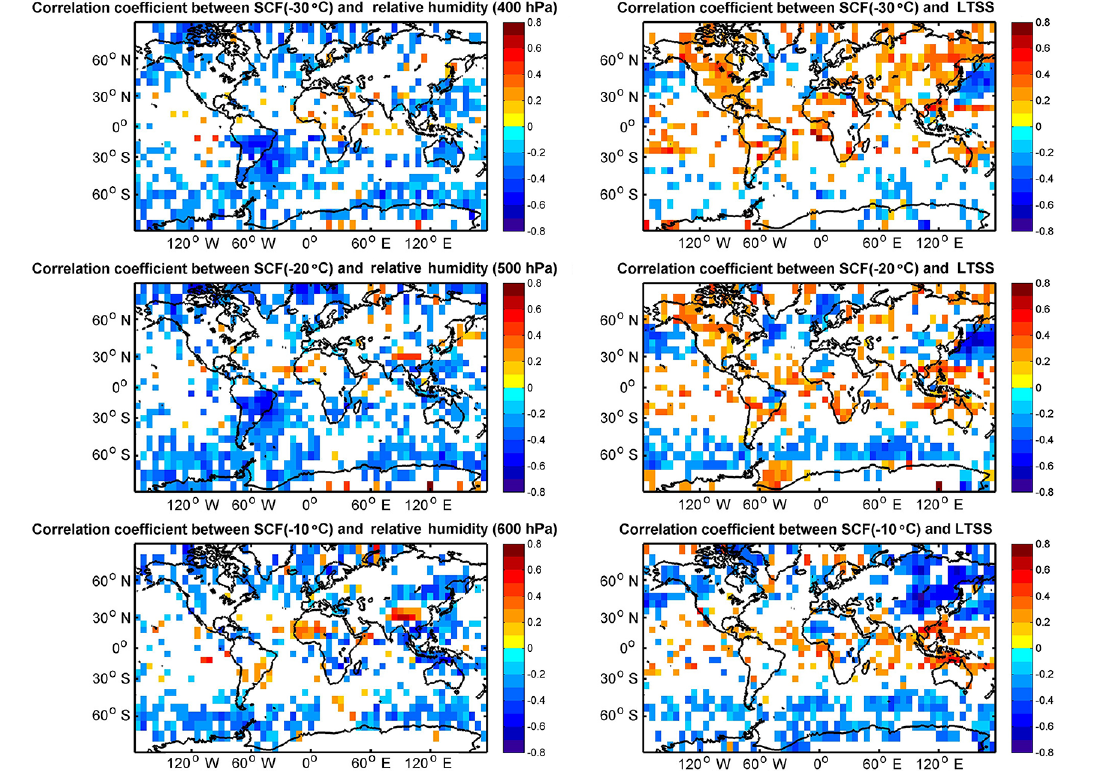
Figure 6. Similar to Fig. 5 but for relative humidity (left panel) and LTSS (right